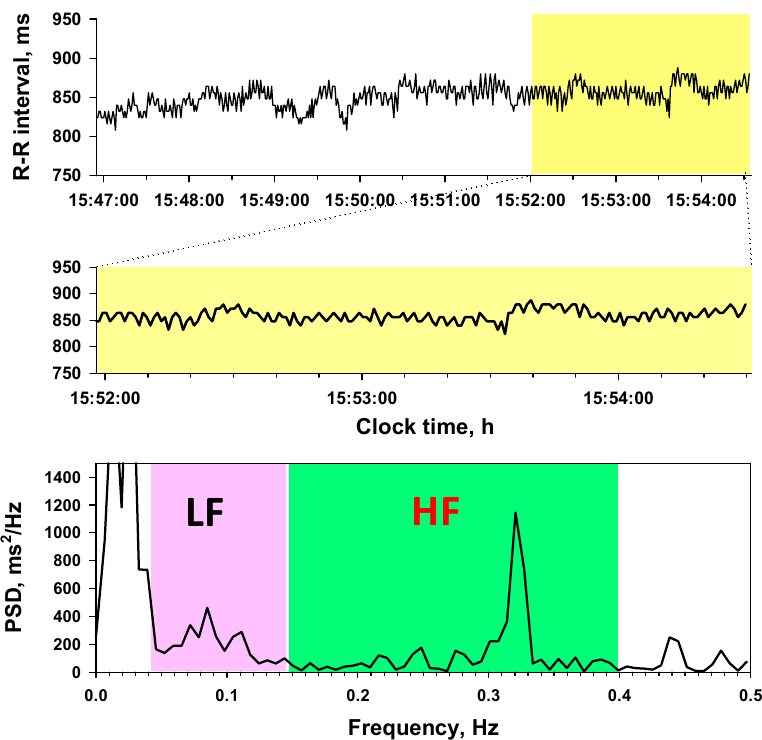
Figure 1. Analysis of heart rate variability (HRV) under sinus rhythm. HF = high-frequency component (0.15–0.4 Hz), LF = low-frequency component (0.04–0.15 Hz), PSD = power spectral density.